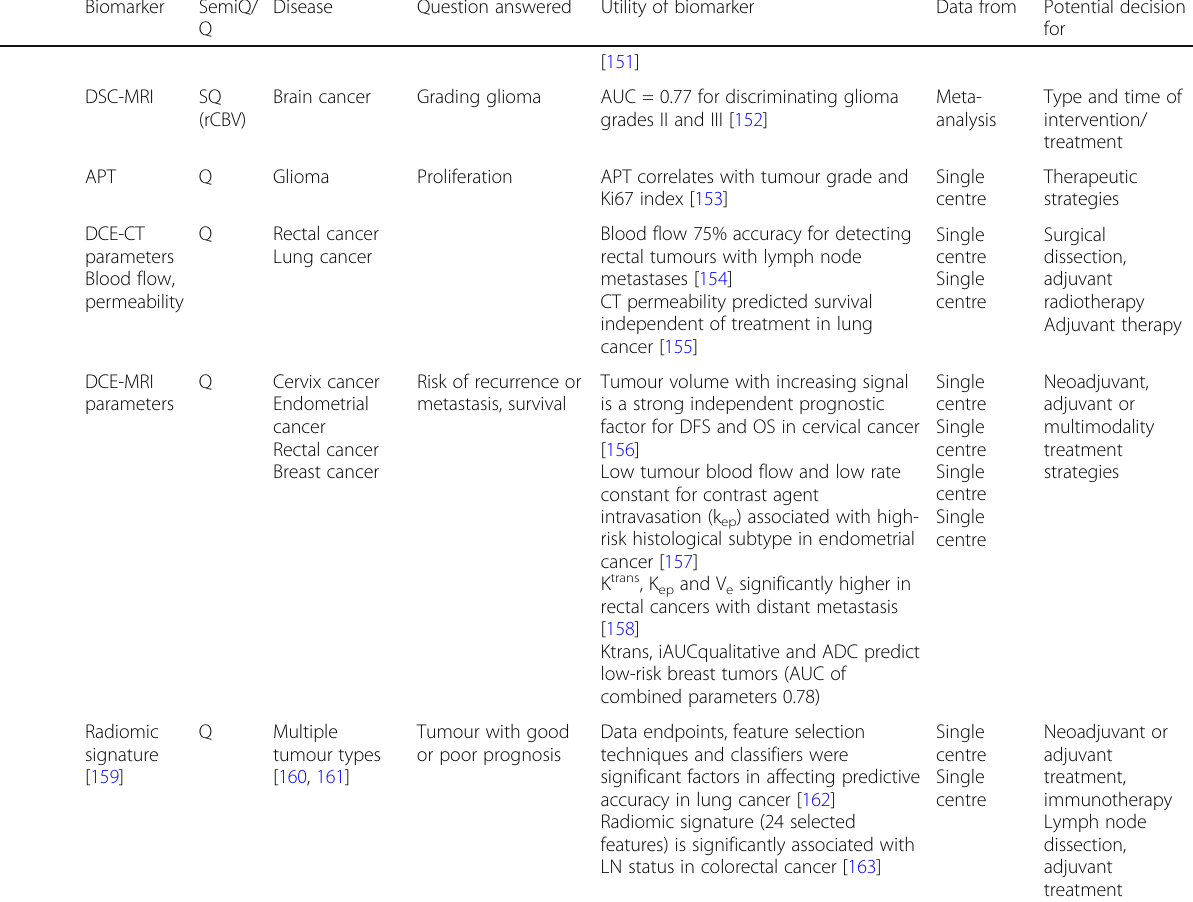
Table 2 Imaging biomarkers for disease characterisation (semi-quantitative and quantitative) with examples of current evidence for their use that would support decision-making